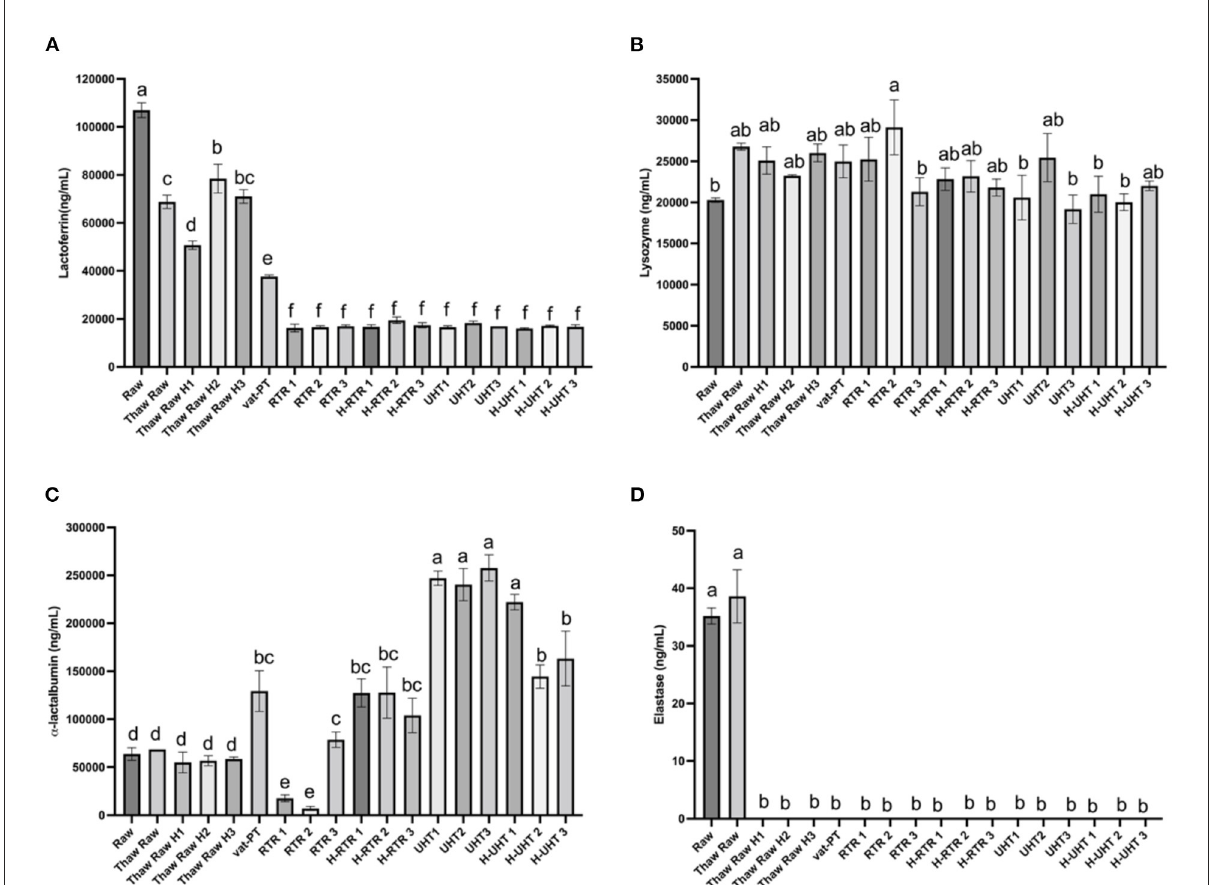
FIGURE3 (A) Lactoferrin, (B) lysozyme, (C) α -lactalbumin, and (D) elastase concentrations in the donor human milk samples: raw milk (Raw), thawed raw milk (Thaw Raw), thawed and homogenized raw milk (Thaw Raw H1, Thaw Raw H2 and v H3), vat-pasteurized milk (Vat-PT), retort treated milk (RTR 1, 2, and 3), homogenized and retort treated milk (H-RTR 1, 2, and 3), ultra-high-temperature treated milk (UHT 1, 2, and 3), and homogenized and ultra-high-temperature treated milk (H-UHT 1, 2, and 3). One-way analysis of variance (ANOVA) with post hoc Tukey’s tests were used to identify significant ( p < 0.05) differences between treatments, denoted by